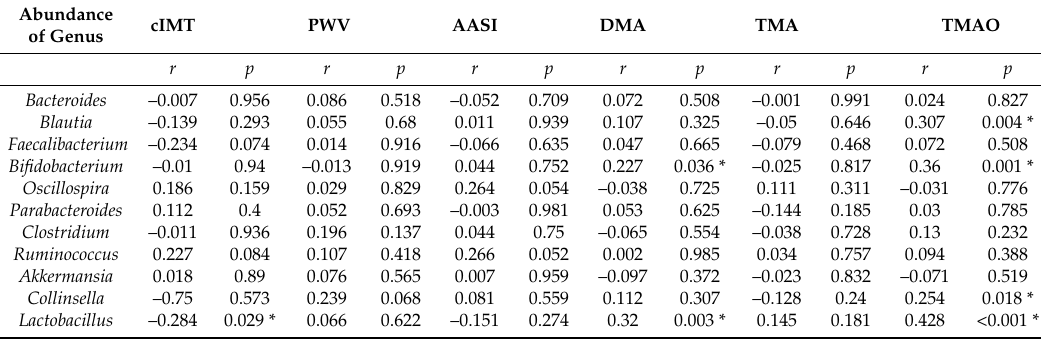
Table 4. Correlation between gut microbial composition and cardiovascular surrogate markers in children with CKD stage